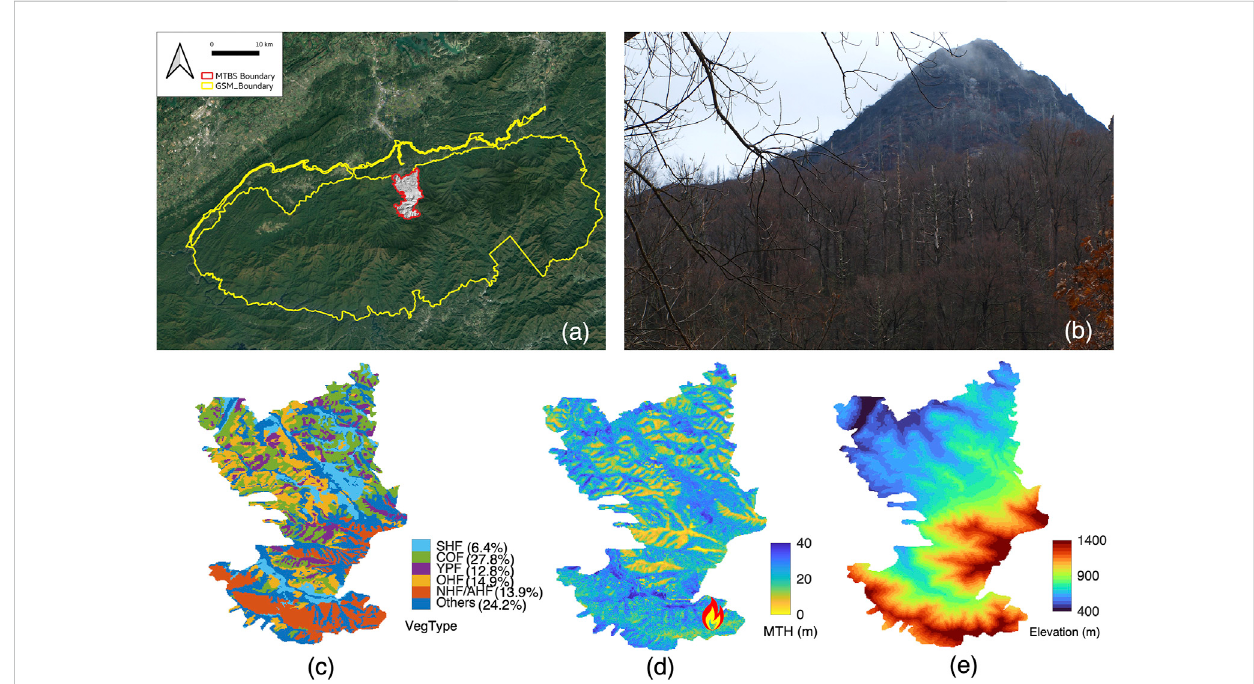
FIGURE 1 Geographicallocationof2016ChimneyTops2wild fi reinGreatSmokyMountainsNationalPark (A) andaviewofburntforestcapturedduring2018s fi eld trip (B) . Spatial distribution of vegetation type (C) , mean forest height (D) , and digital elevation (E) over the study region. A fi re marker in panel (D) indicates the location of the fi rst fi re ignition of the CT2 fi re. In panel (C) , HF, COF, YPF, OHF, and NHF/AHF stand for successional hardwood forest, chestnut oak forest, yellow pine forest, oak-hickory forest, and northern hardwood/acid hardwood forest,